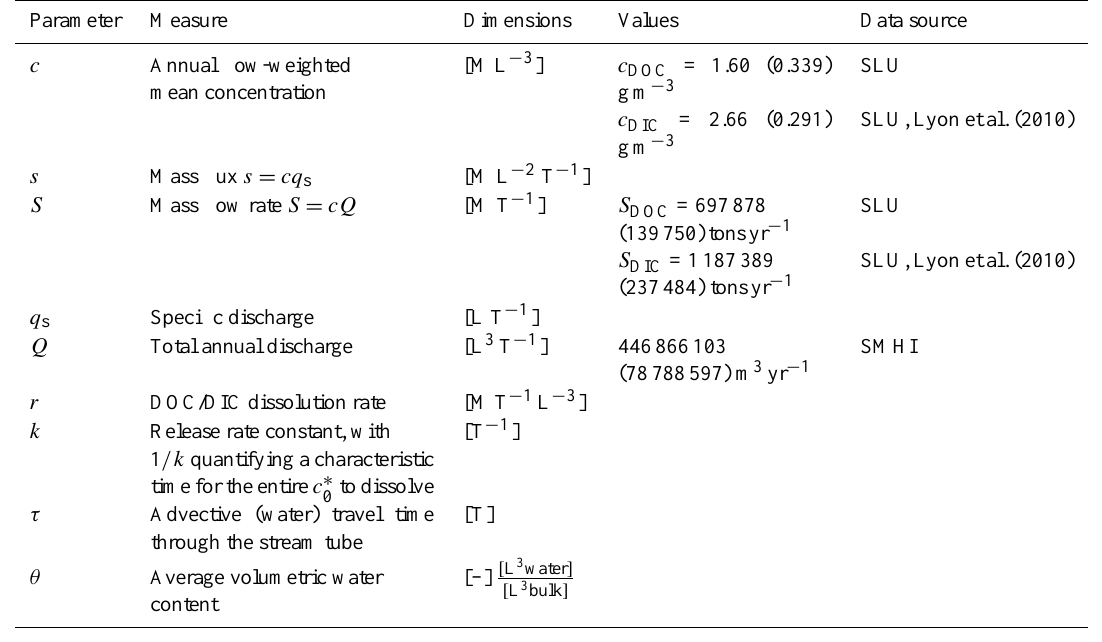
Table 1. Model parameters and estimated parameter value estimates (standard deviation within parentheses) for the Abiskojokken catchment.